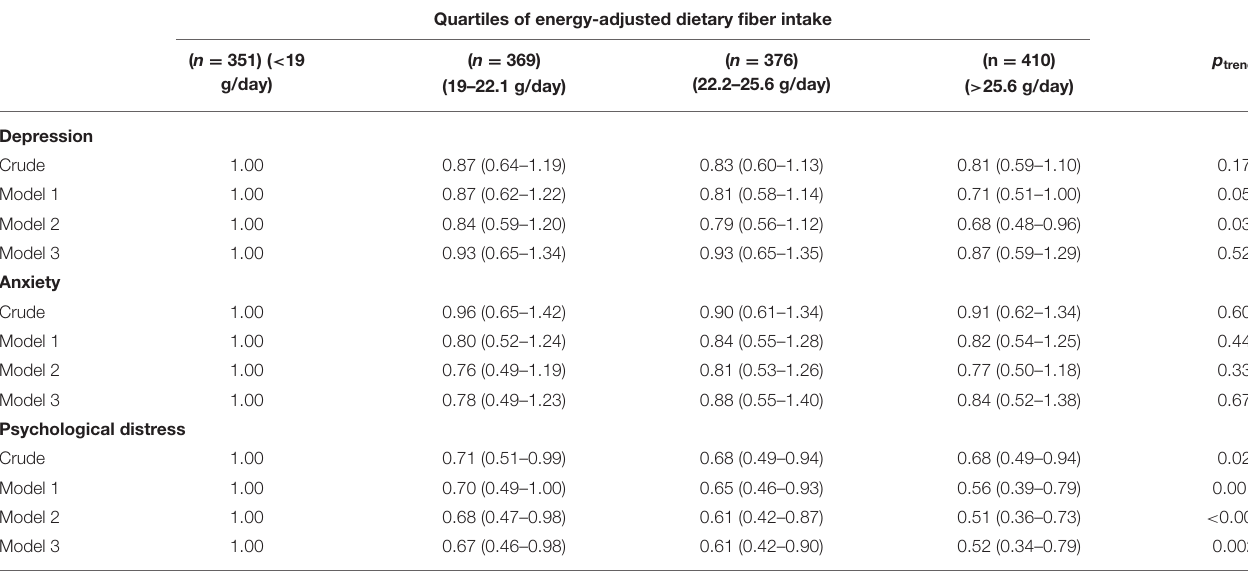
TABLE 6 | Multivariable-adjusted odds ratios and 95% confidence intervals for depression, anxiety, and high psychological distress across quartiles of energy-adjusted dietary fiber intake in overweight or obese participants [body mass index (BMI) ≥ 25 kg/m 2 ] ( n = 1,506) a . Quartiles of energy-adjusted dietary fiber